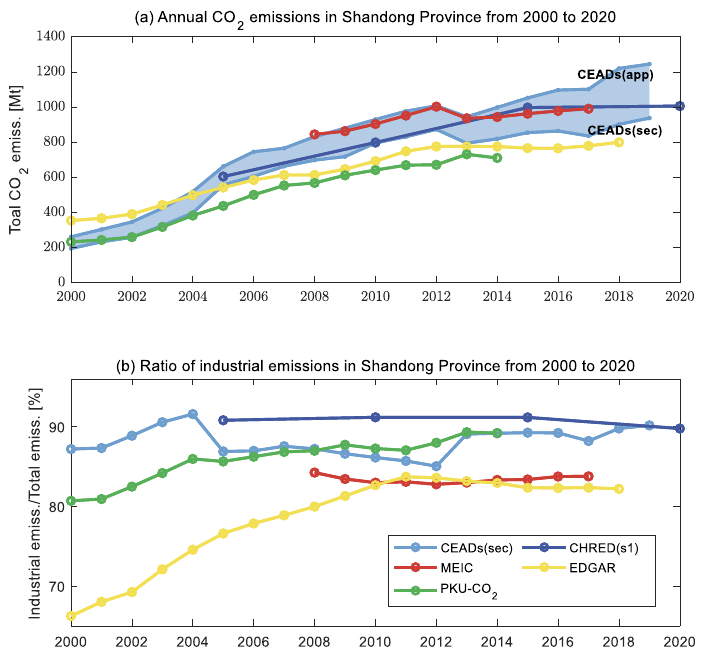
Figure 1. Annual CO 2 emissions during from 2000 to 2020 ( a ) and industrial emission ratios ( b ) from multi-inventories for Shandong province.